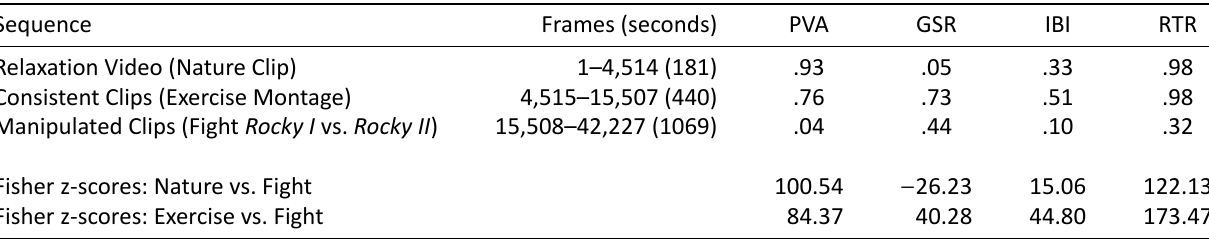
Table 1. Pearson correlations between the two conditions for the different process measures across the three stimulus sequences.